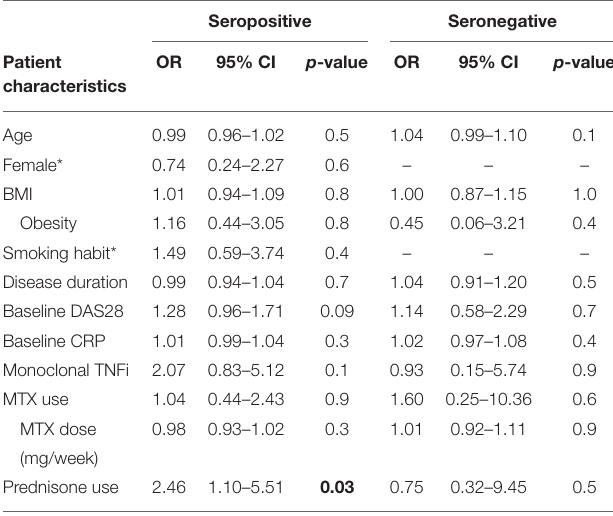
TABLE 3 | Association between patient characteristics and TNFi discontinuation (univariable analysis), stratified by seropositivity.